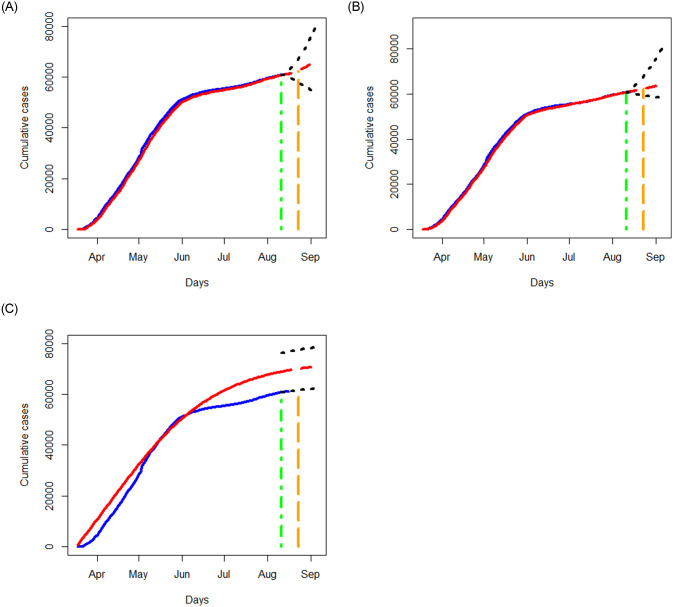
Analysis of cumulative numbers of infected cases with COVID-19 in Quebec, Canada using the STAR, NN and SIR models: Fitted values (in red) versus the reported cumulative infections (in blue).A red dashed curve represents the prediction for the next 25 days. Black dotted lines represent 95% prediction bands. The curves prior to the green vertical line are obtained for the training data; the red dashed curves show the predicted values where the green vertical lines indicate the start date of prediction. A region between green and orange dashed lines reflects a short term prediction, and a region after the orange dashed line shows a long term prediction.